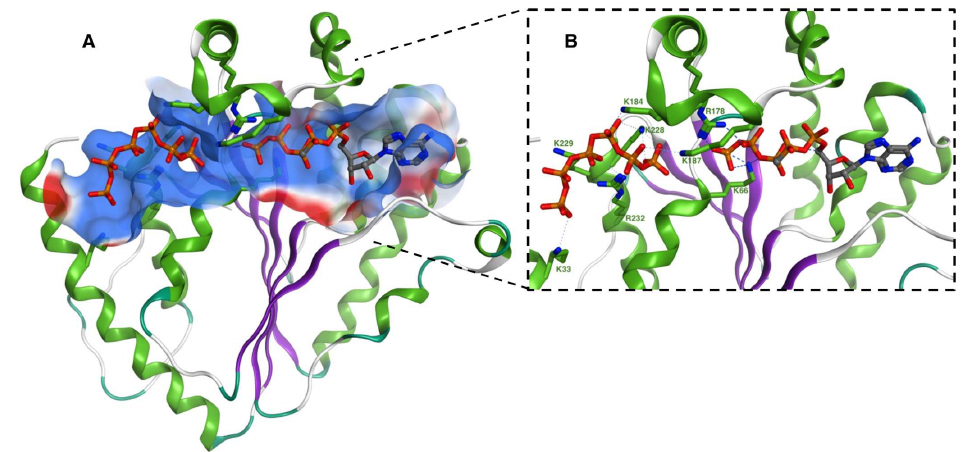
Figure 2. PPK2 substrate binding sites elucidated via co-crystallization with polyP and nucleotide ligand. F. tularensis PPK2 (green and purple) bound to polyP and the nucleotide AMP-PCH2PPP (PDB ID 5LLB) [53]. ( A ) Electrostatic surface representation of the polyP binding channel. Blue and red represent positive and negative charge, respectively. ( B ) Detailed view of the amino acid residues that mediate polyP binding. Interactions indicated by blue dashed lines. Figure created in Molecular Operating